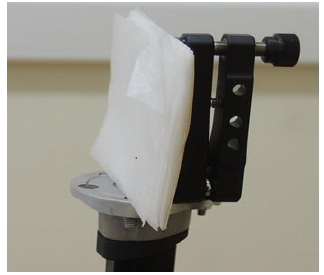
Figure 6. Sample with thin paper layers.